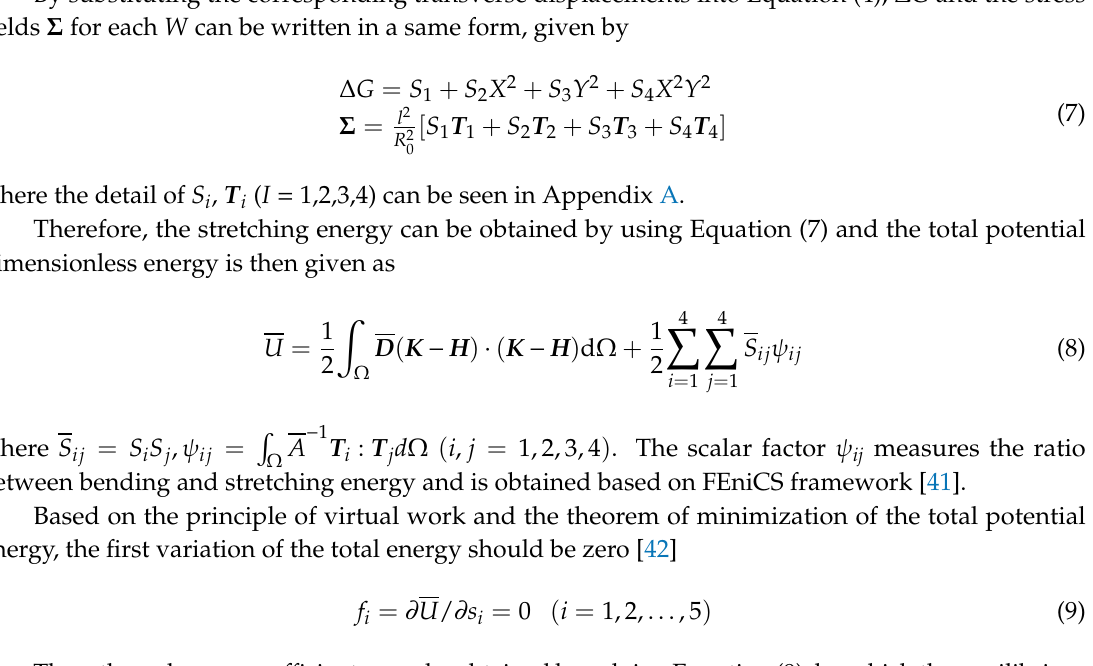
Figure 1. Geometrical parameters of cylindrical shells with different planform shapes.